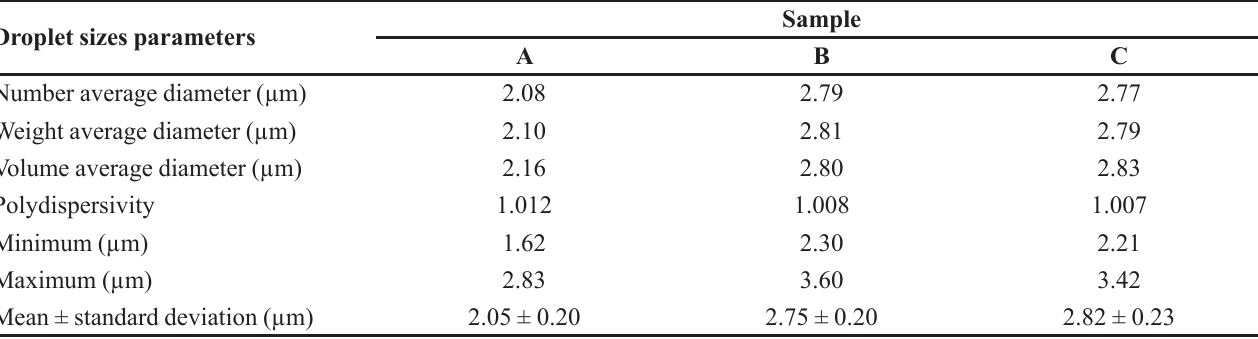
TABLE II - Droplet sizes parameters of formulations A, B and C Droplet sizes